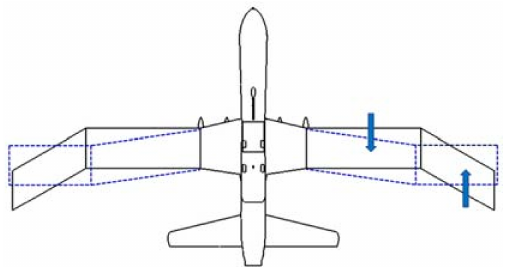
Figure 6. Schematic diagram of the wing deformation mode for multi-section variable-sweep wing UAV based on the centroid self-trim compensation, in which the sweep angle of the inner section gradually increases from 0 ◦ while the sweep angle of the outer section decreases to 0 ◦